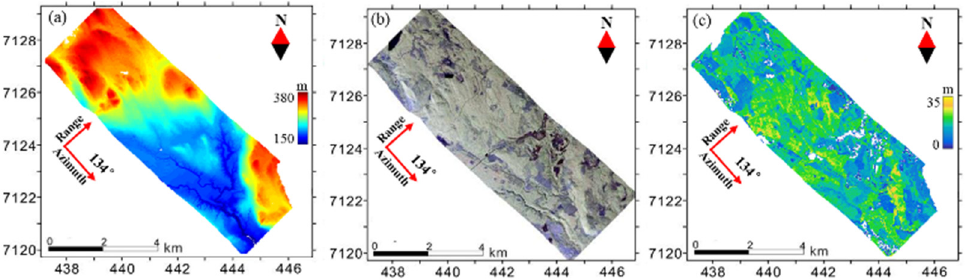
Figure 5. Image of the study area: ( a ) LiDAR-derived DEM. ( b ) Pauli-basis polarization composite map for the L-band SAR data (R: HH − VV; G: HV; B: HH + VV). ( c ) LiDAR-derived CHM.